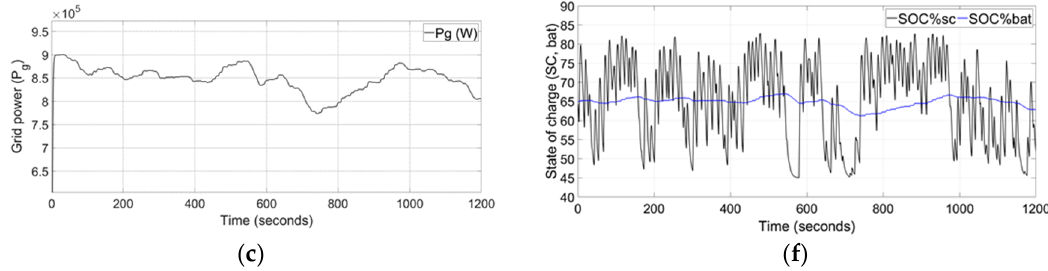
Figure 4. Second case study. ( a ) Power comparison of VOWC generators combined power (P s_total ,), grid power (P g ), and supercapacitor power (P sc ), ( b ) Li-ion battery power (P bat ), ( c ) grid power (P g ), ( d ) state of charge of the of the battery (SOC bat ) ( e ) DC-link Voltage (v dc ), ( f ) state of charge of the supercapacitor (SOC sc ) and battery (SOC bat ).